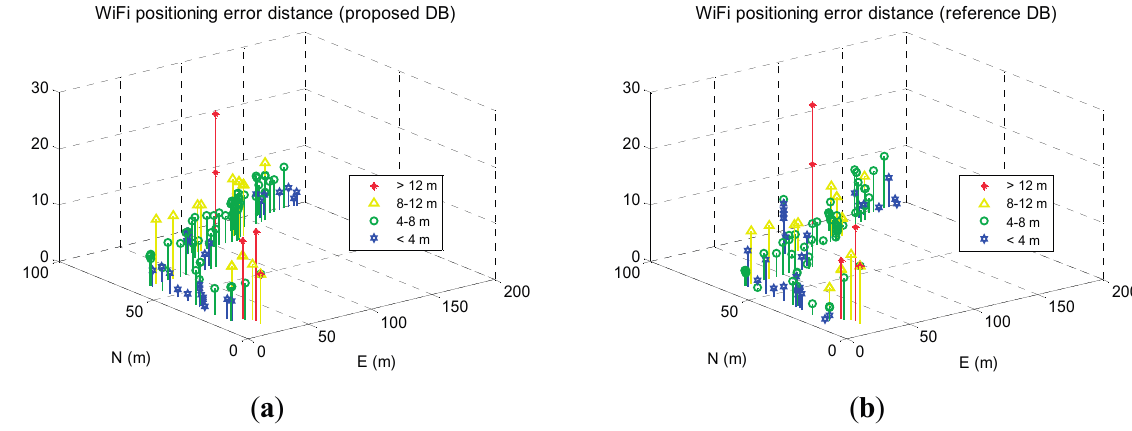
Figure 19. WiFi fingerprinting result using proposed DB ( a ) and that using reference DB ( b ).